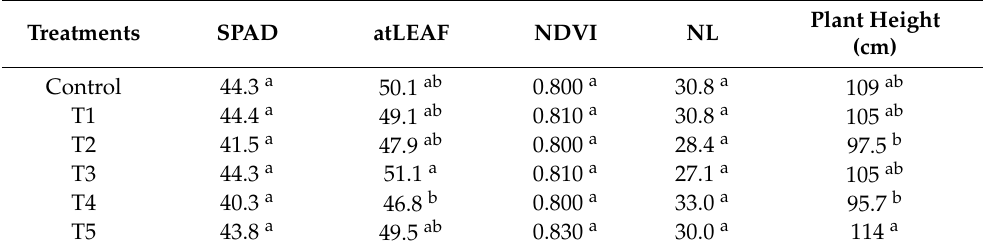
in November and March), T4 (30 g) + (15 g in November) and T5 (45 g) + (15 g in November and March).